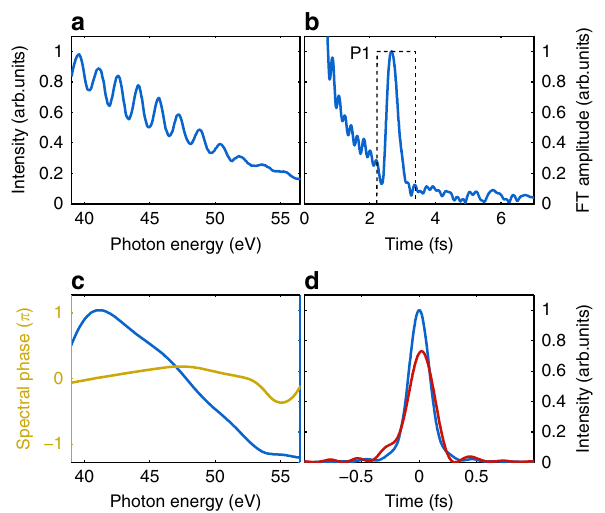
Fig. 3 Spectral interferometry with two APs. a Measured XUV spectrum with ϕ CEP ≈ 0 and L / λ L ≈ 0.25 in a selected spectral range. b Corresponding FT using the 39 – 57 eV range. The peak P1 represents the interference of the two involved APs. Dashed line shows temporal gate function chosen for the subsequent inverse FT. c Reconstructed combination of two AP spectra p ffiffiffiffiffiffiffiffiffiffiffiffiffiffiffiffiffi S S S (blue) and their phase difference ϕ P1 = ϕ AP1 − ϕ AP2 P1 ¼ AP1 AP2 without the linear term (yellow). y Axis scale and ticks for spectral intensity match the y axis of next plot. d Fourier-limited (blue) and phase-affected (red) AP temporal structure based on S P1 and ϕ P1 . The delay between the pulses is removed for better